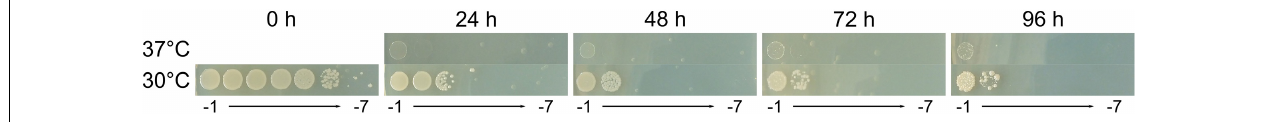
FIGURE 1 | Tenfold serial dilution of a stationary phase culture of CH34 spotted on LB agar plates and incubated at 37 ◦ C (upper row) for 0, 24, 48, 72 and 96 h before shifting to an 48 h incubation period at 30 ◦ C (lower row).